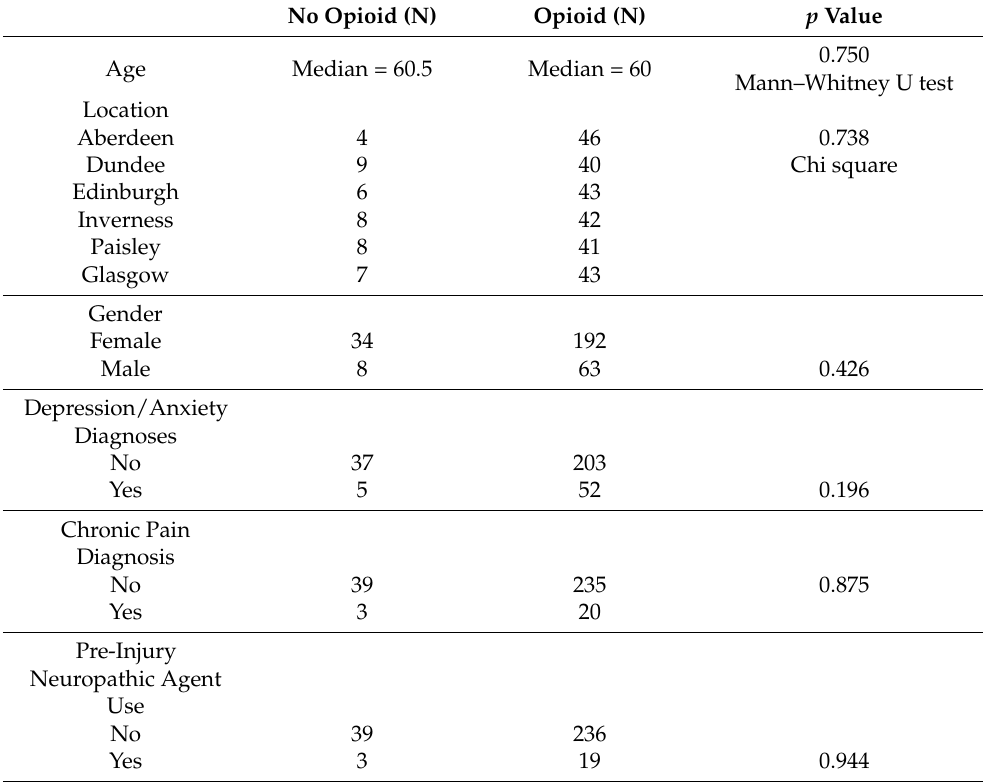
Table 4. Univariate analysis of wrist fracture